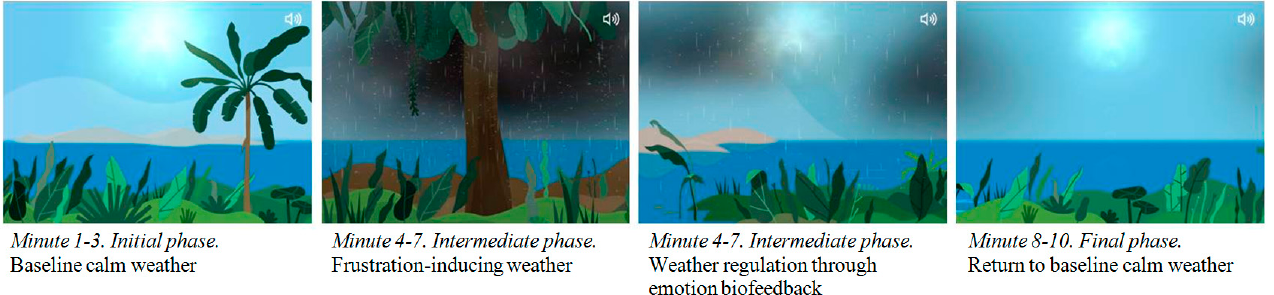
Figure 2. Animation sequence of the application e-Estesia.